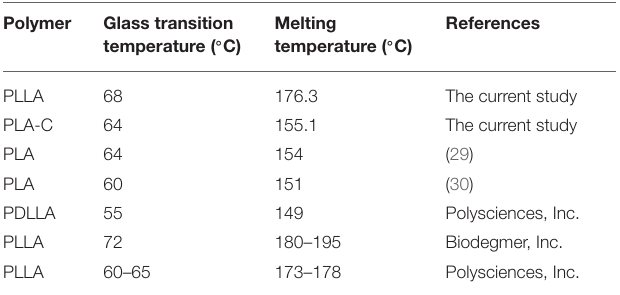
TABLE 1 | Thermal properties of the poly (L-lactic acid) (PLLA) synthesized in this study compared to commercial PLA, PDLLA, and PLLA. Polymer